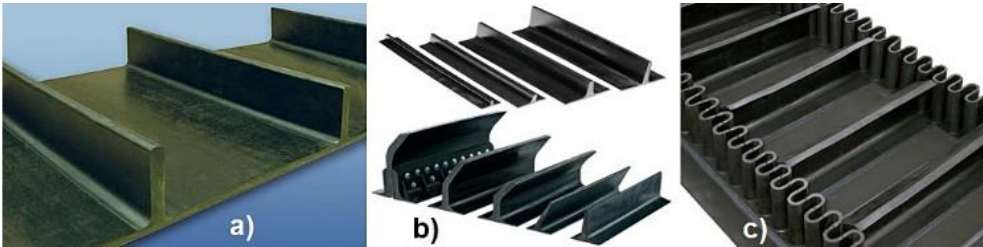
Figure 2. Conveyor belt ( a ) with belt cleats, ( b ) types of belt cleats, ( c ) with belt cleats and corrugated side edges.